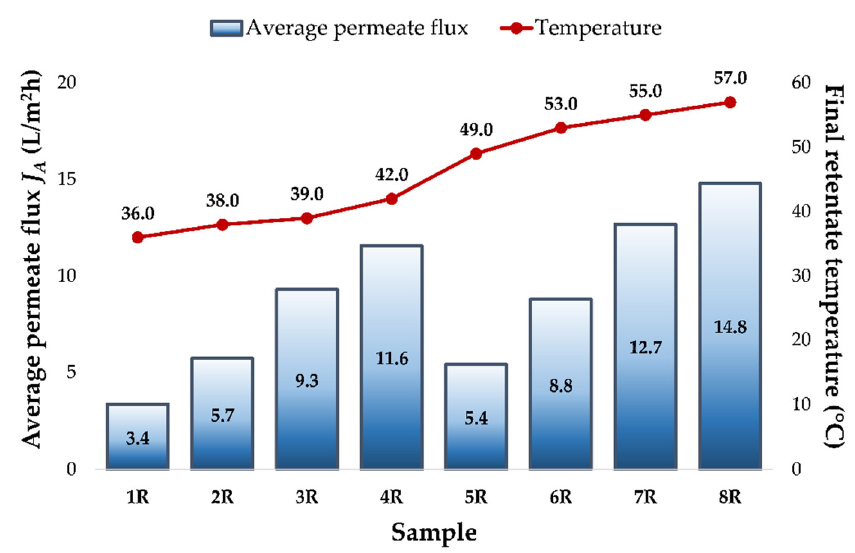
Figure 1. Average permeate flux J A (L/m 2 h) and the final retentate temperature at different applied pressures (2.5, 3.5, 4.5 and 5.5 MPa), with and without cooling, during the concentration of the conventional and ecological Cabernet Sauvignon red wines by reverse osmosis. Abbreviations: R—reverse osmosis process; 1—2.5 MPa, with cooling; 2—3.5 MPa, with cooling; 3—4.5 MPa, with cooling; 4—5.5 MPa, with cooling; 5—2.5 MPa, without cooling; 6—3.5 MPa, without